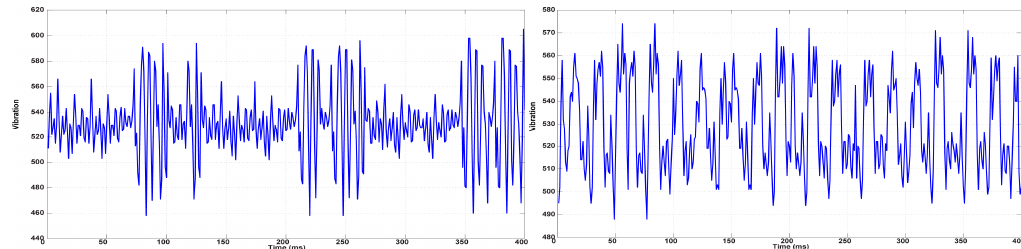
Figure 34. Vibration signal collected by the acceleration sensors for a faulty gear (left) and good gear (right).